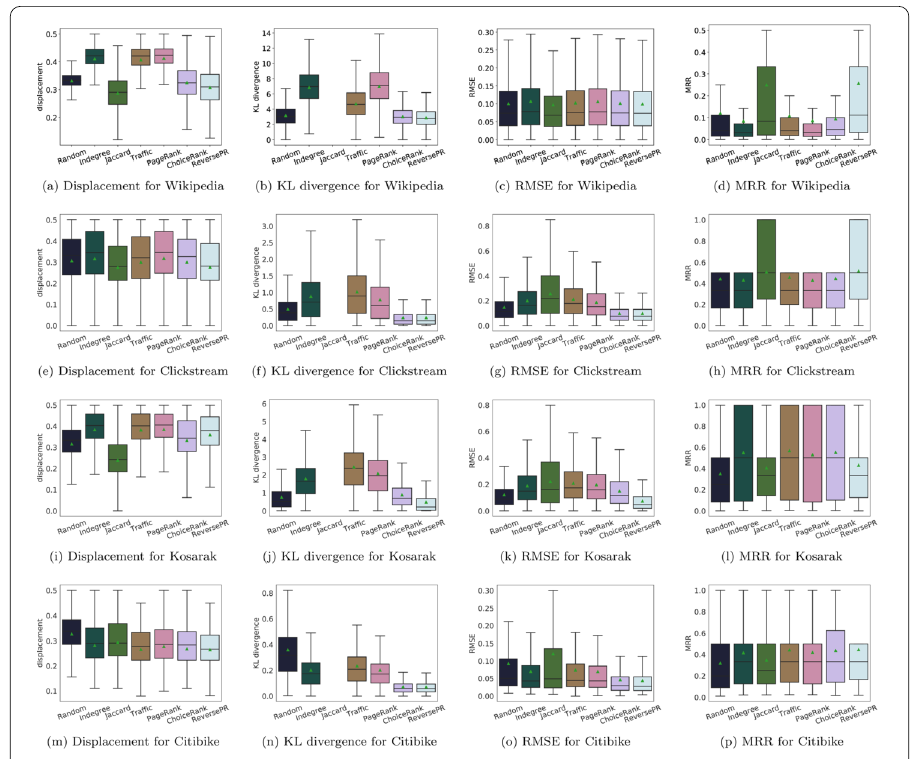
Figure 11 Box plots of the different evaluation metrics aggregated over the vertices of various datasets. The triangles mark average